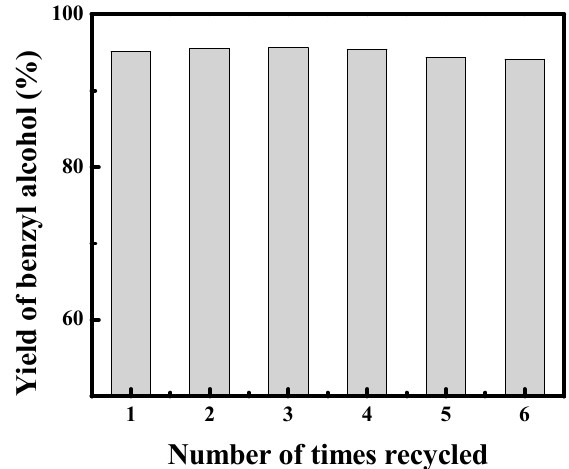
Figure 5. The results of the recycling experiments of the γ -Fe 2 O 3 @HAP-Pd catalyst. Reaction conditions: Benzaldehyde (1 mmol), γ -Fe 2 O 3 @HAP-Pd catalyst (10 mg), H 2 O (10 mL), 10 bar H 2 , 25 °C and 1 h.